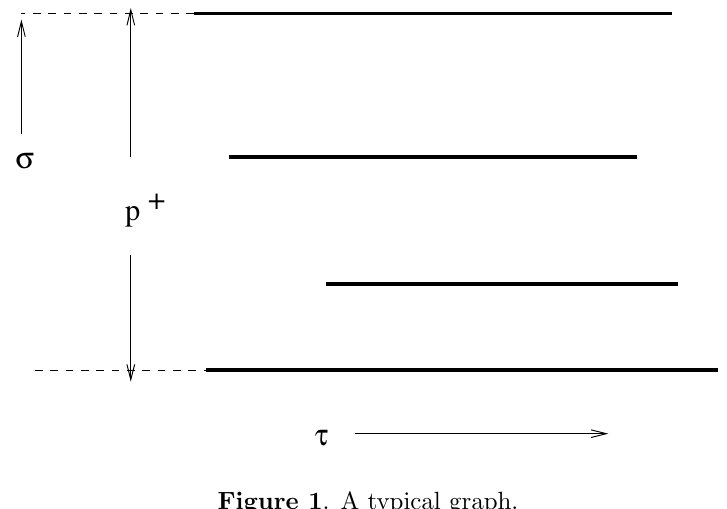
Figure 1 . A typical